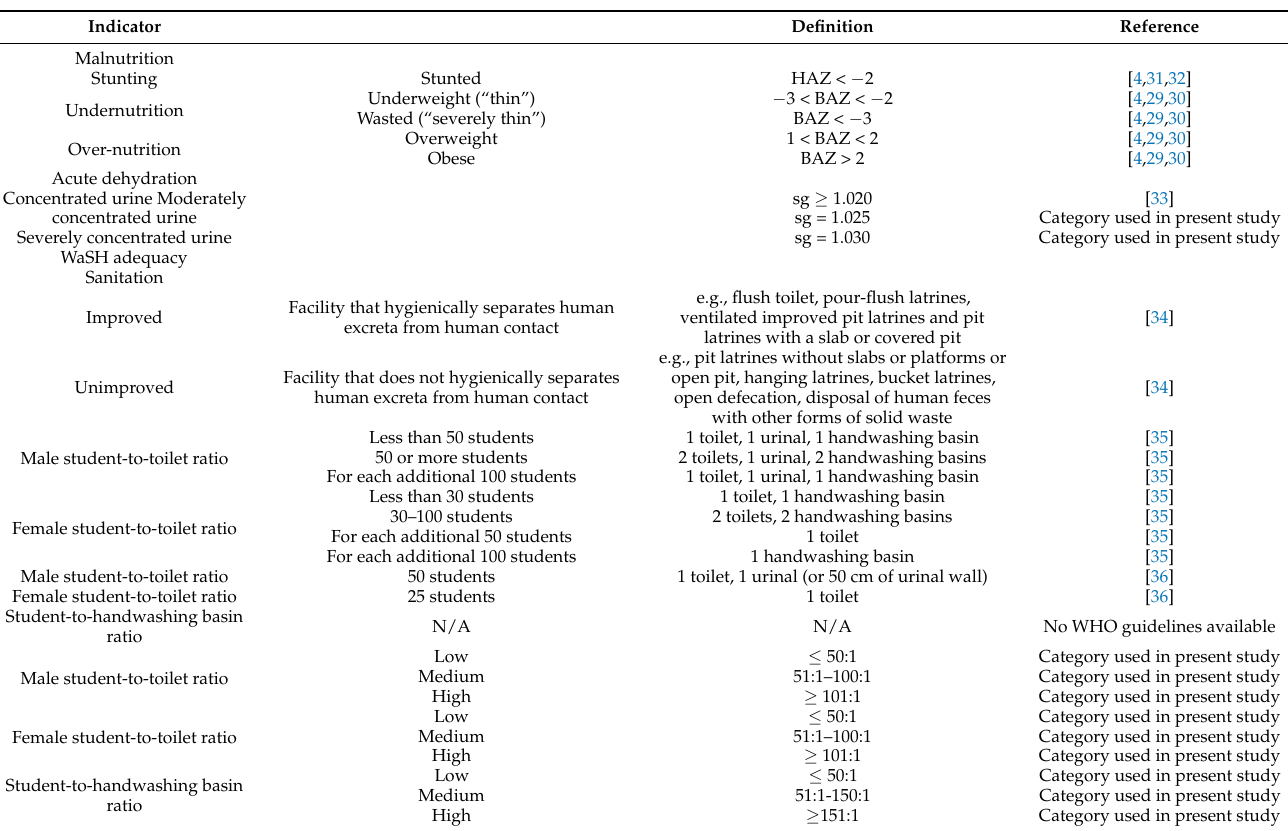
Table 1. Operational